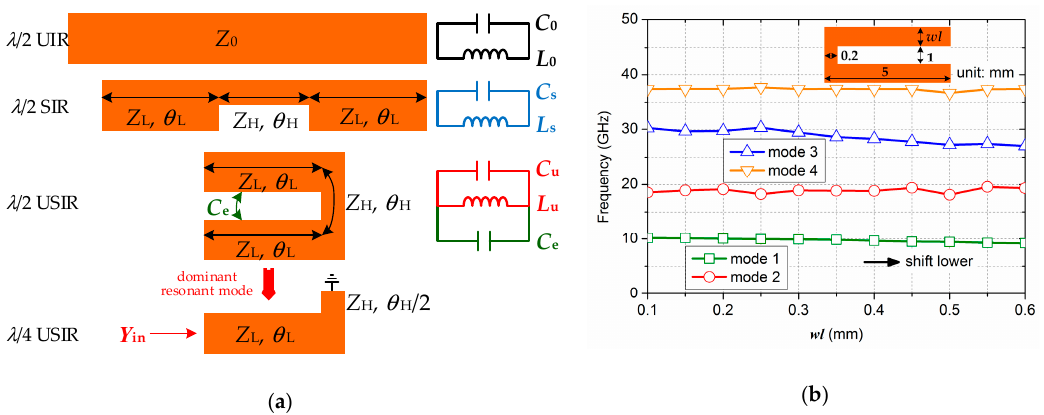
Figure 2. Geometry and resonant frequency of the U-shaped stepped impedance resonator (USIR): ( a ) Geometries and equivalent-circuit models of the uniform impedance resonator (UIR), stepped impedance resonator (SIR), and USIR; ( b ) resonant frequencies of the lowest four modes in the USIR versus width of the low-impedance section.